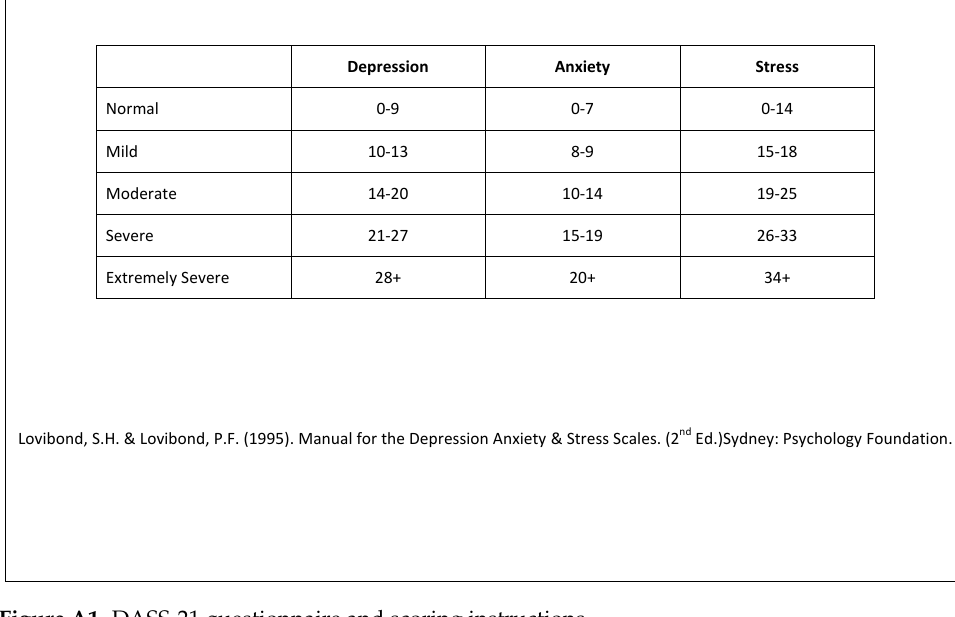
Figure A1. DASS-21 questionnaire and scoring